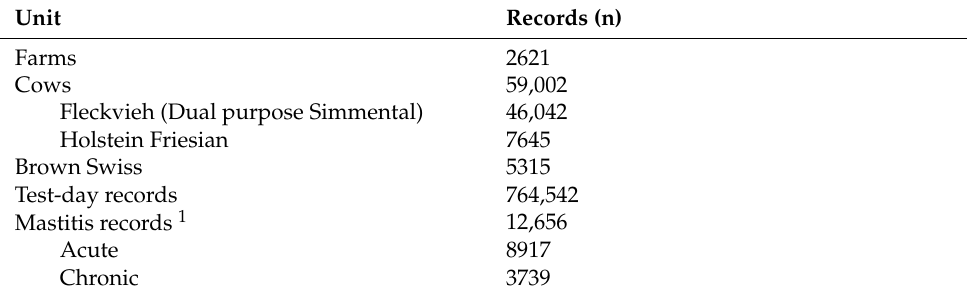
Table 1. Properties of the dataset used for